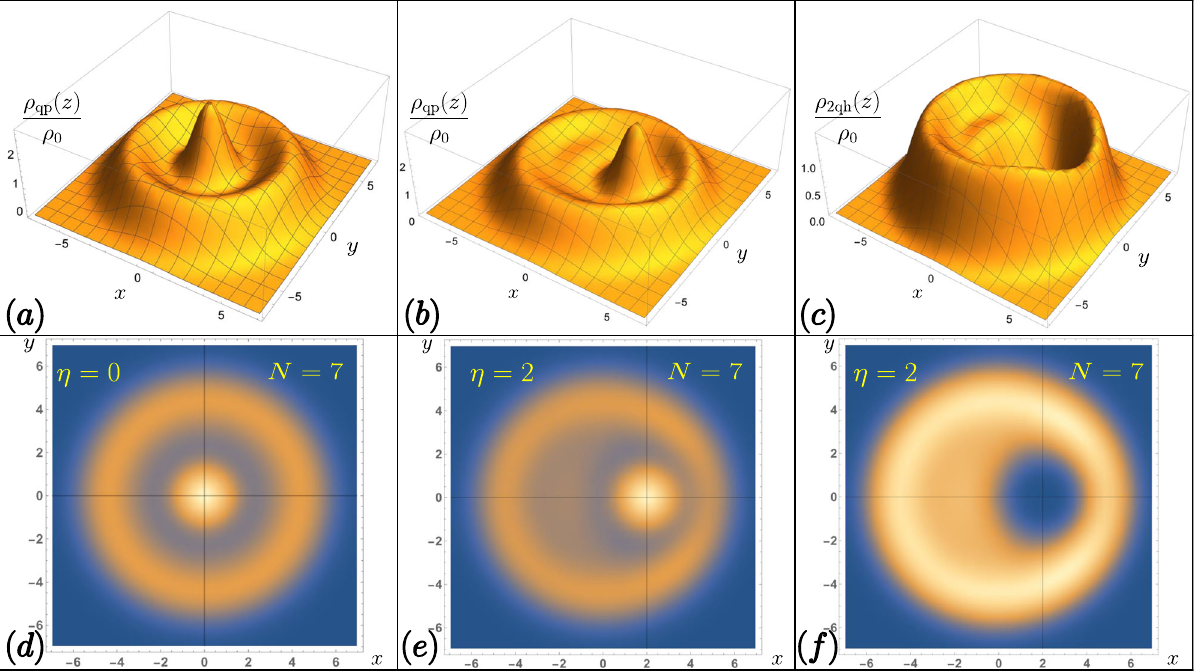
¼ ν ) for one quasielectron 0 2 π